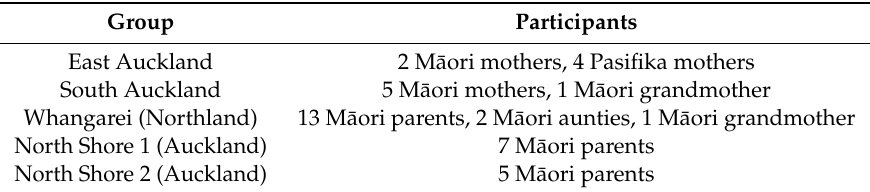
Table 1. The composition of M¯aori focus groups.